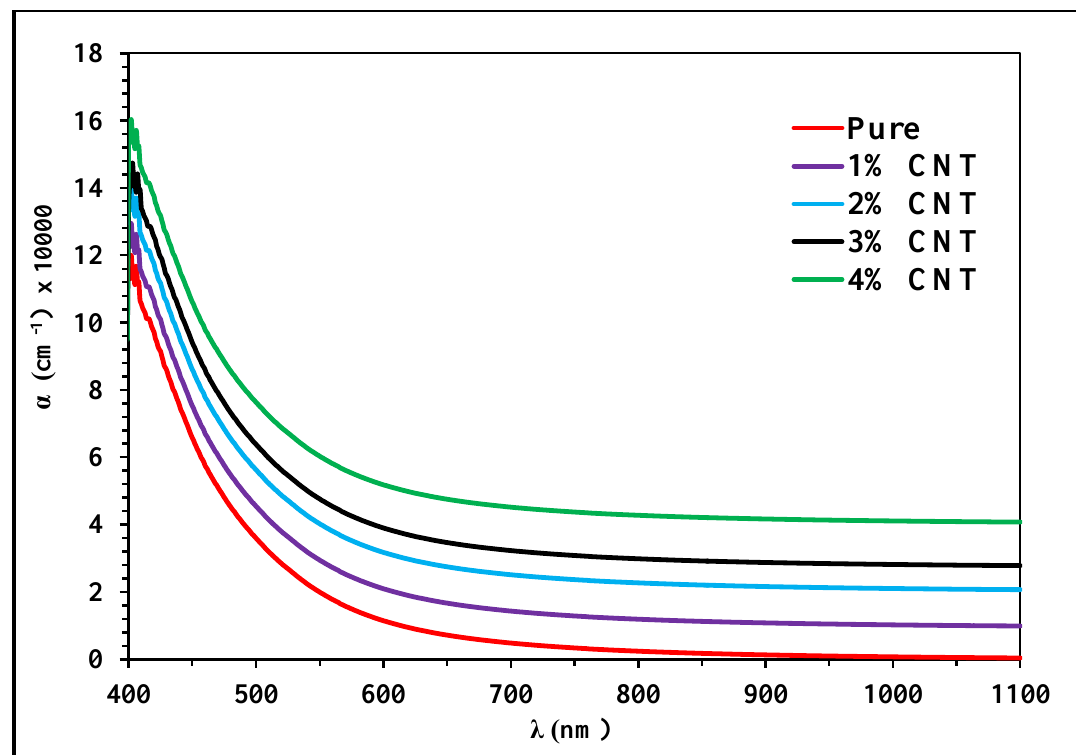
Fig. 5: Absorption coefficient of the pure PANI and